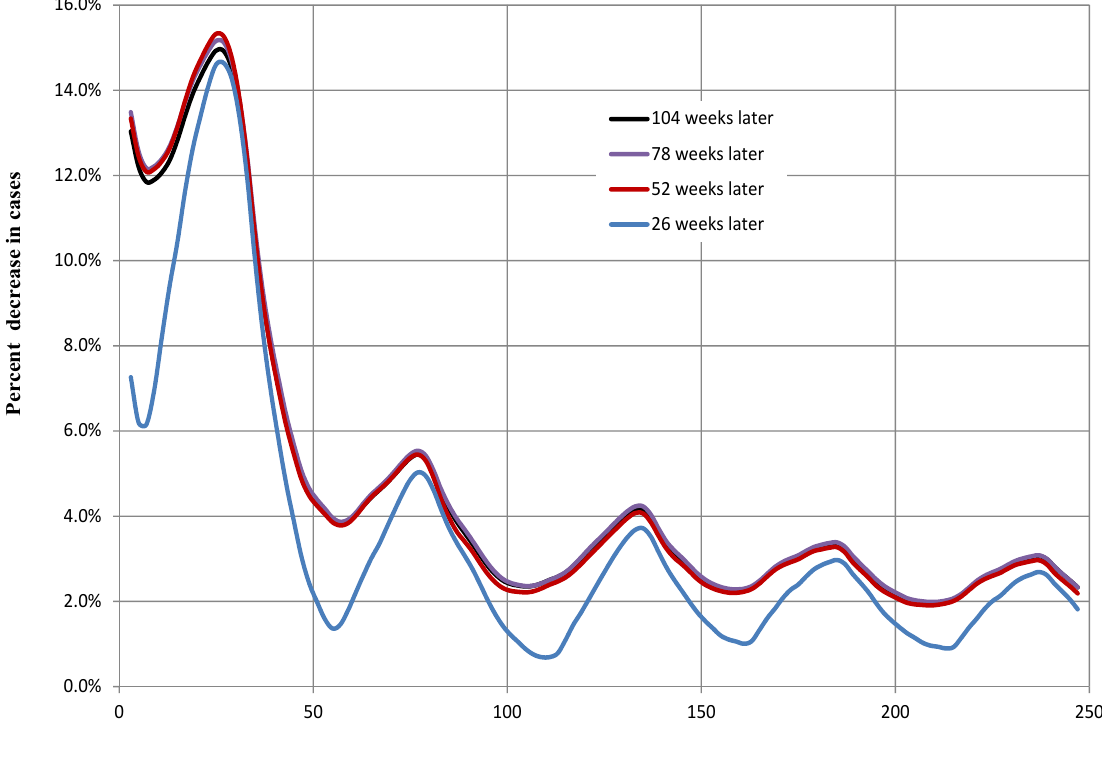
Figure 14. Artibonite. The percent decrease in the total number of cases 26, 52, 78 and 104 weeks after the beginning of the second round of vaccination indicated on the abscissa. The onset of the immune response was assumed to begin a week later. We assume 70% efficacy of the